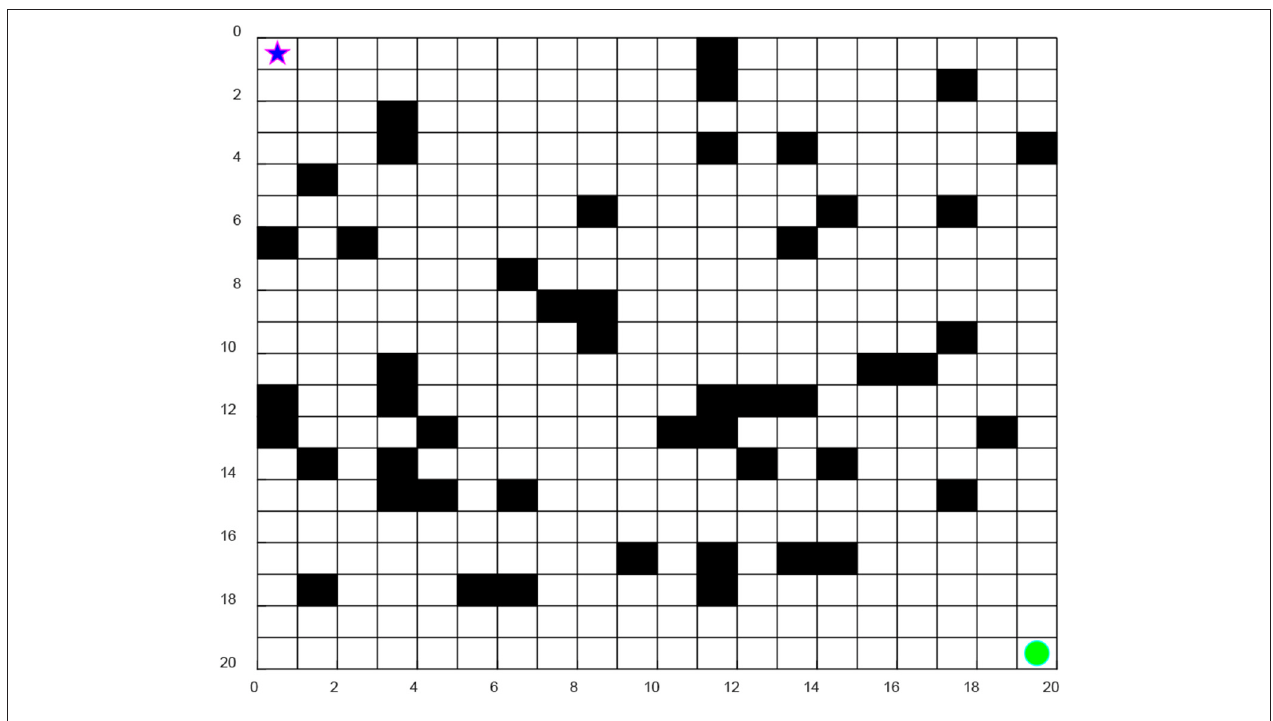
FIGURE 1 | Environment modeling.